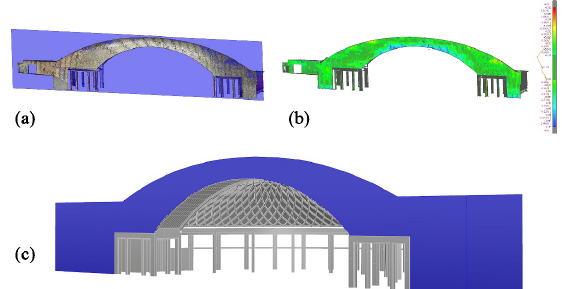
Figure 10 . (a) Best-fitting plane (least-squares interpolation). (b) Discrepancies analysis between the generated plane and the primary data (point cloud). (c) NURBS modelling.